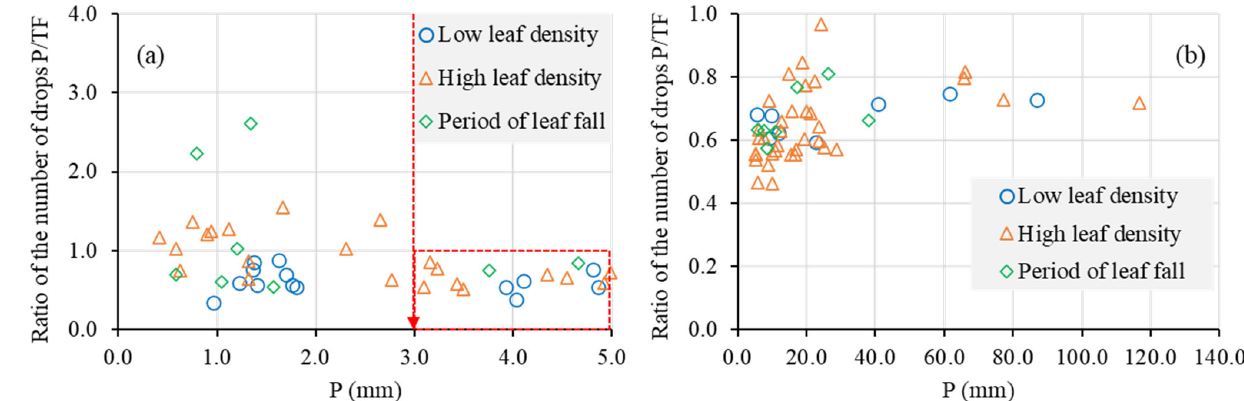
Figure 6. Ratio of the total number of drops of the gross rainfall (P) and throughfall (TF) in relation to total rainfall (P) for the three stages of canopy development for ( a ) P ≤ 5.0 mm and ( b ) P > 5.0 mm. The red line indicates the rainfall threshold for the number of drops of TF to be higher than for P. The rainfall threshold for the number of drops of TF to be higher than for P was 3.0